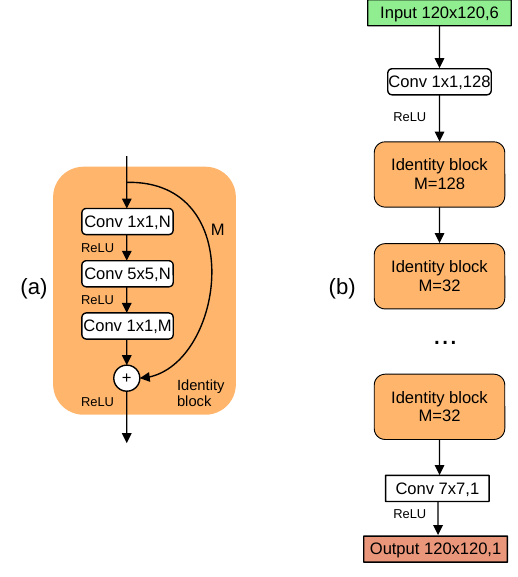
Figure 8. ResNet architecture: ( a ) linear block (ResNet) and ( b ) regression